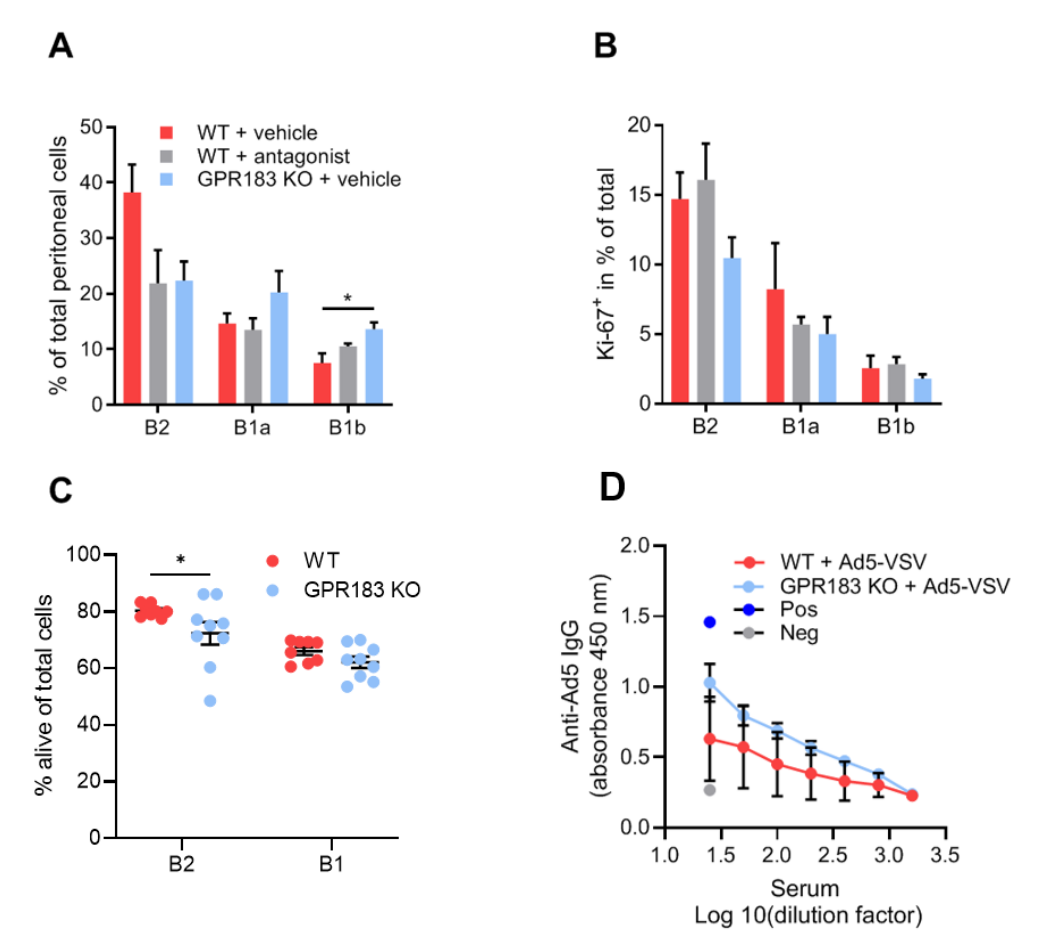
Figure 3. Effects of lack of GPR183 expression or GPR183 signaling on peritoneal cavity B cell frequencies, proliferation, apoptosis, and function; ( A ) and ( B ) mice were given the GPR183 antagonist NIBR189, or vehicle alone, by gavage twice daily for one week. After one week, their peritoneal cavity cells were analyzed by flow cytometry; ( A ) percentages of the indicated B cell subsets in the peritoneal cavity of antagonist-treated WT mice and vehicle-treated WT and GPR183 KO mice; ( B ) percentages of cells of the indicated B cell subsets which are positive for the Ki-67 proliferation marker in antagonist- and vehicle-treated WT mice and vehicle-treated GPR183 KO mice. Error bars represent mean ± SEM of data from 4–5 mice of 17–39 weeks of age. * p < 0.05 by one-way ANOVA; ( C ) percentages of alive cells in B cell subsets from the peritoneal cavity of GPR183 KO and WT mice as determined by flow cytometry (living cells do not stain with Annexin V or PI). Error bars represent mean ± SEM of data from 8–9 mice of 11–15 weeks of age. * p < 0.05 by one-tailed unpaired t -test with Welch’s correction; ( D ) mice were vaccinated with 10 9 Ad5-VSV virus particles i.p., and 14 days later serum samples were taken and analyzed for Ad5-specific IgG by ELISA. Error bars represent mean ± SEM of data from 4 mice, aged 21–22 weeks. Pos = positive control serum sample known to have anti-Ad5 IgG antibodies. Neg = negative control serum sample from mouse vaccinated with unrelated antigen.